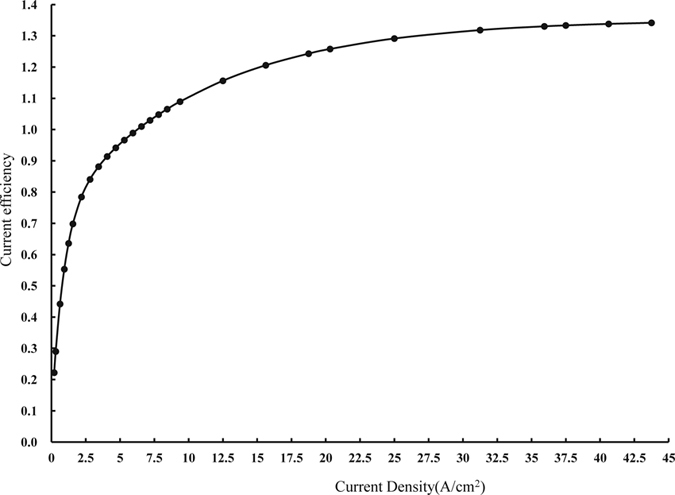
Current efficiency curve of Ti-6Al-4V in 10% NaNO3 electrolyte.